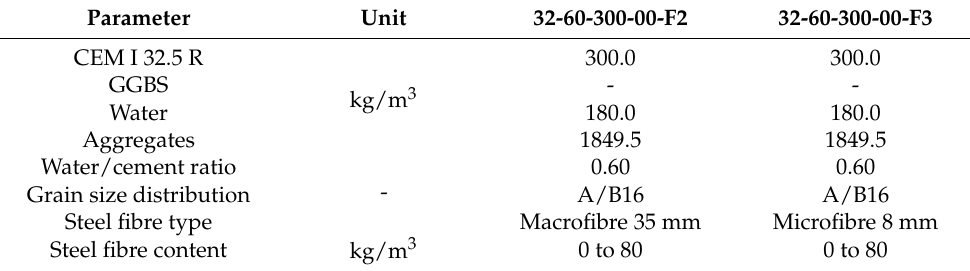
Table A5. Concrete mix designs for the variation of the steel fibre type.